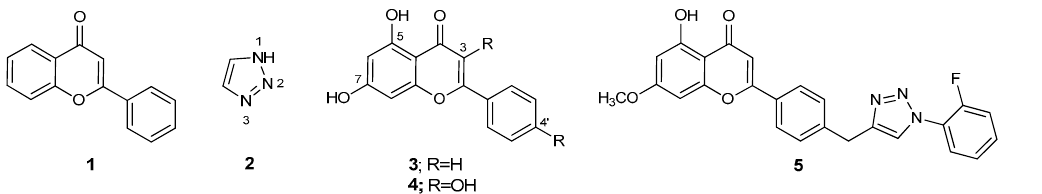
Figure 1. The structure of 2-phenylchromen-4-one ( 1 ), 1,2,3-triazole ( 2 ), chrysin ( 3 ), kaempferol ( 4 ), and an anticancer flavone—1,2,3-triazole hybrid ( 5 ).